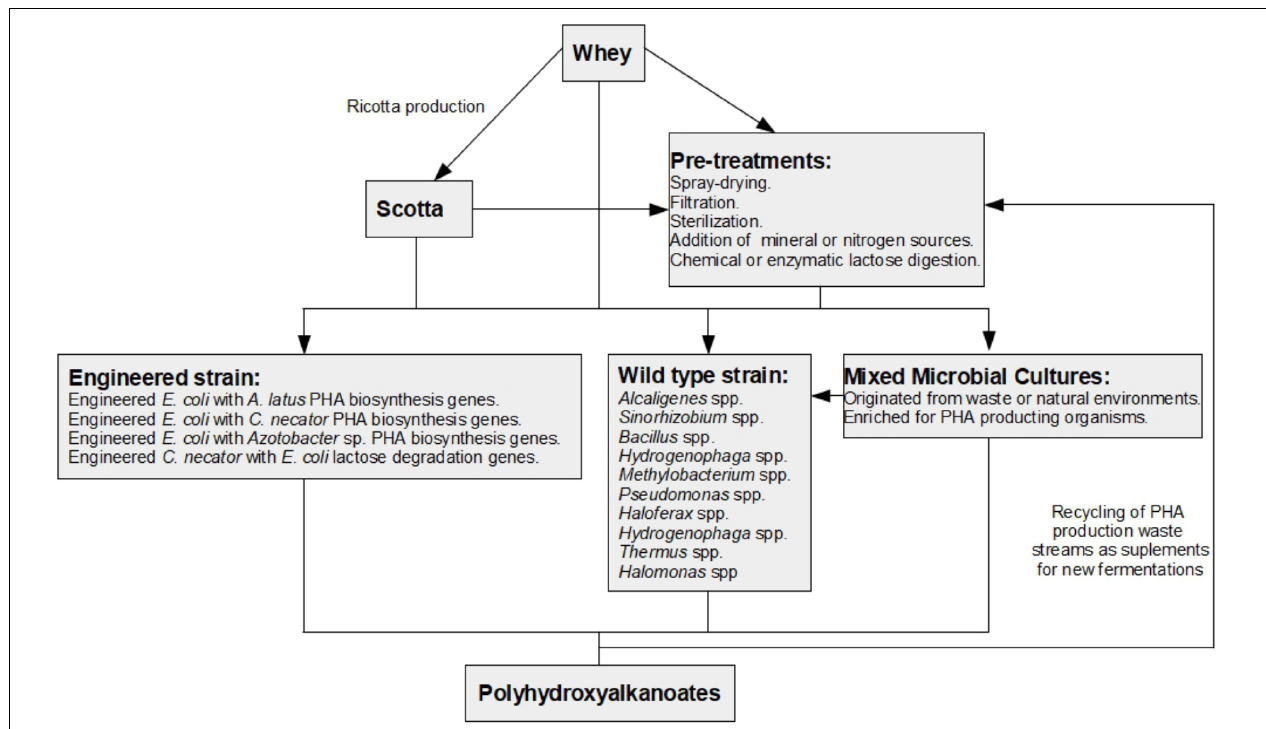
FIGURE 1 | Schematic diagram of possible pathways for the production of polyhydroxyalkanoates from whey. Whole whey can be directly used in fermentations that produce PHAs. However, pre-treatments are normally used to generate efficient PHA production. Production of ricotta cheese from whey generates a by-product called ricotta cheese whey or scotta . Scotta can be used directly or after undergoing pre-treatments for PHA production. PHA production from whey can be achieved by using organisms that occur in nature and are capable of producing PHAs from whey or whey derivatives (wild-type strains); engineered strains enhanced for PHA production or lactose consumption (engineered strains); or mixed microbial cultures (MMCs) that can originate from waste streams or nature and can be enriched in PHA producing microorganisms usually using feast and famine cycles. During PHA production, waste streams are generated that can be used as additives for new fermentations from whey or scotta